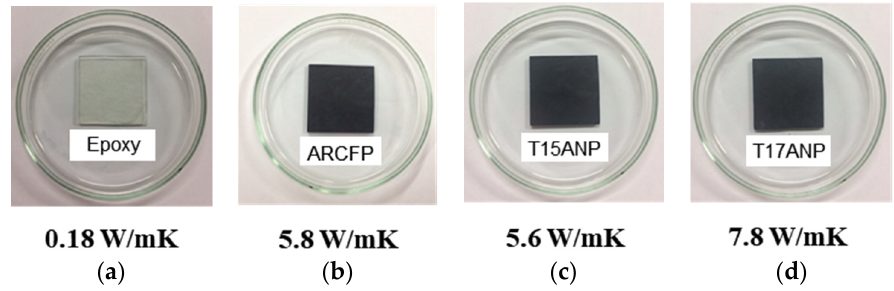
Figure 6. Thermal conductivity of carbon fibers ‐ reinforced composites before and after AlN coating on fiber surfaces: ( a ) neat cured epoxy; ( b ) ARCF reinforced polymer composites (ARCFP); ( c ) T15ANP; and ( d ) T17ANP.